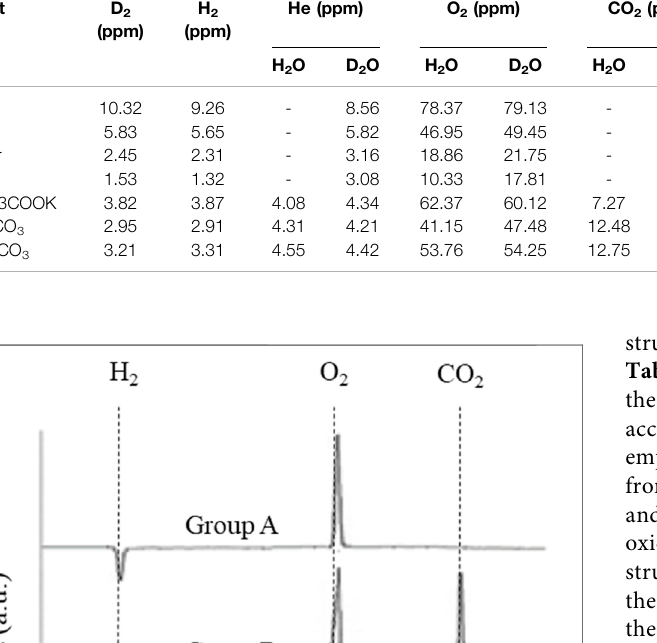
TABLE 1 | Quantitative analysis of generated gases in seven selected salts in both solvents. Salt